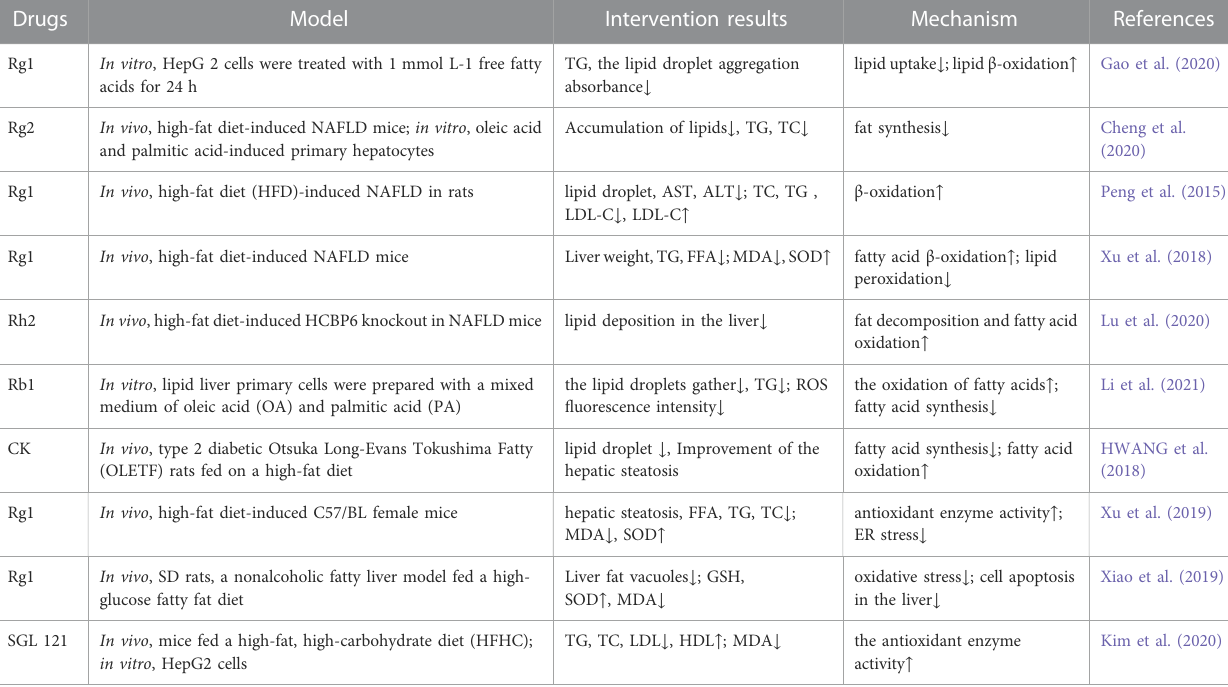
TABLE 5 Ginsenosides inhibit oxidative stress in the treatment of nonalcoholic fatty liver